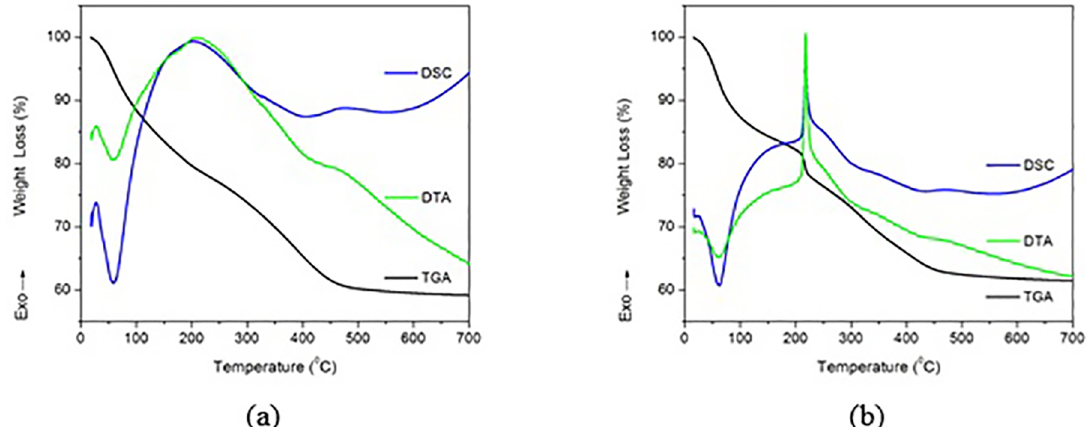
Figure 2. Thermal evolution curves - Thermogravimetric analysis (TGA), differential thermal analysis (DTA) and differential scanning calorimetry (DSC) - lyophilized precursor sol of: (a) Al